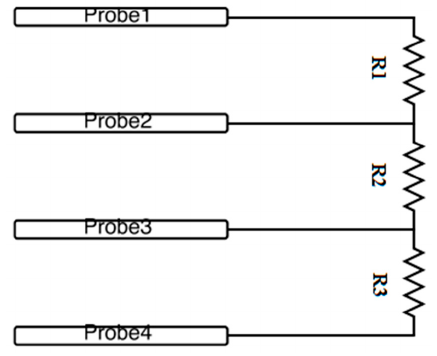
Figure 10. Discrete resistor measurement circuit.